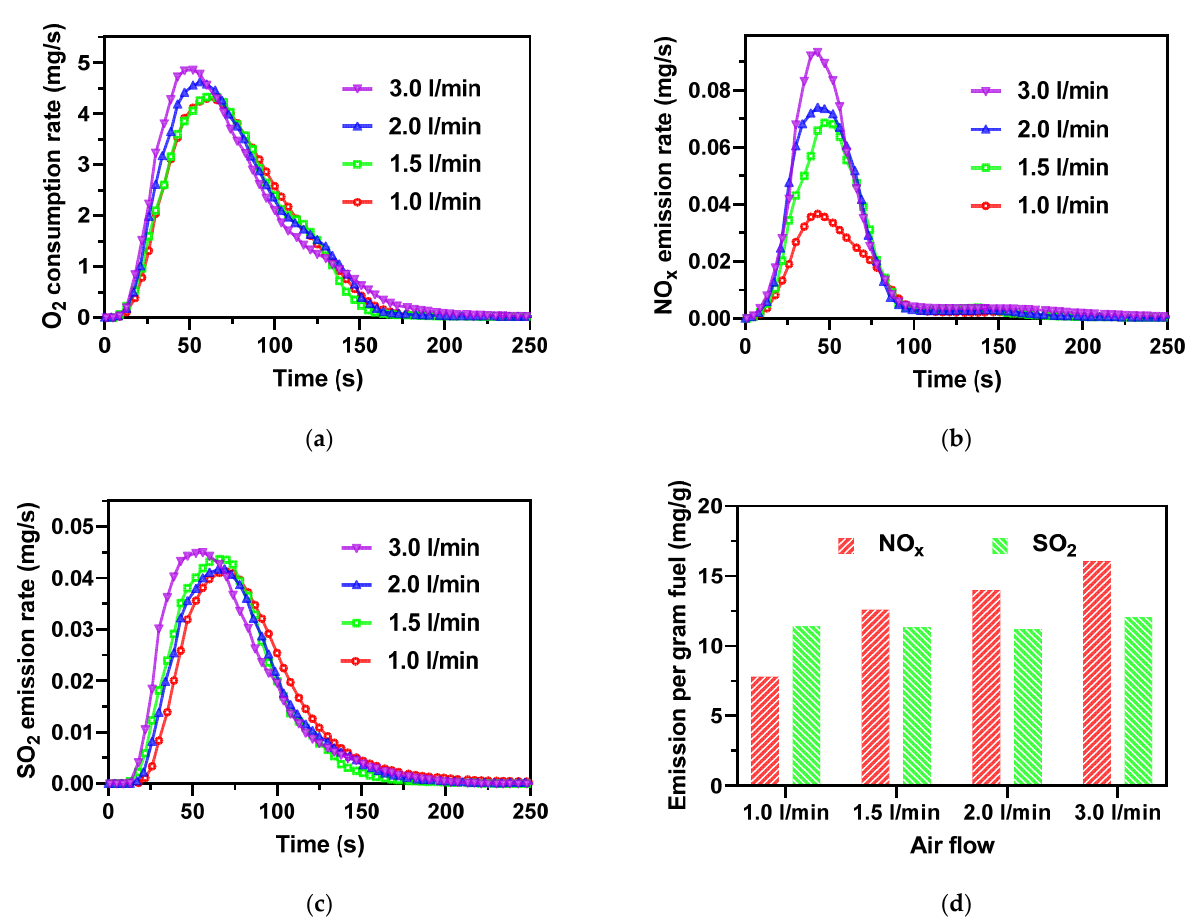
Figure 5. ( a ) O 2 consumption, ( b ) NO x emission, ( c ) SO 2 emission as a function of time during com- bustion of the AMR, and ( d ) NO x and SO 2 emissions per gram AMR at different airflows.